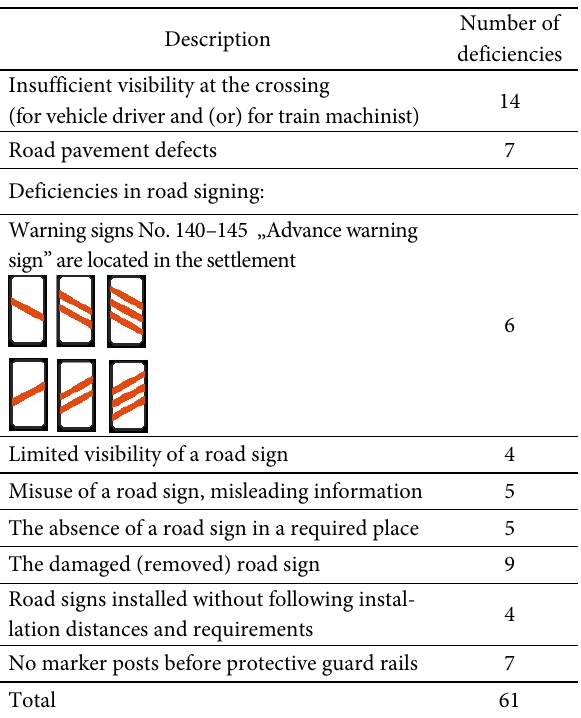
Table 1. Deficiencies determined during the